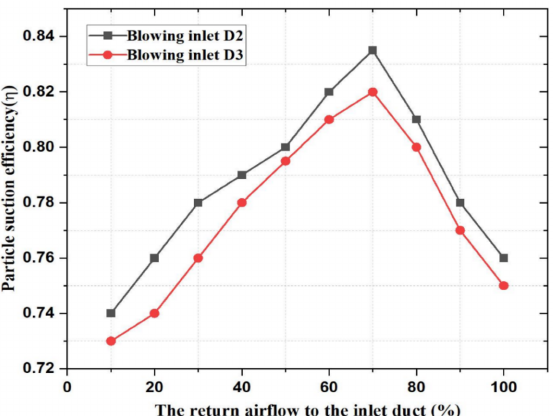
Figure 17. The effect of the airflow returning to the inlet duct on the effective removal of particles.